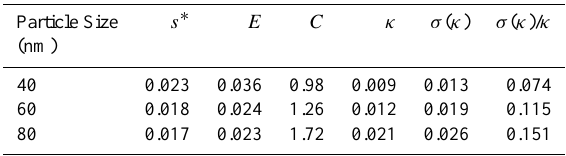
Table A1. Average uncertainty values for fitted ( s ∗ , E , and C ) and derived ( κ , σ ( κ ) and σ ( κ )/ κ )